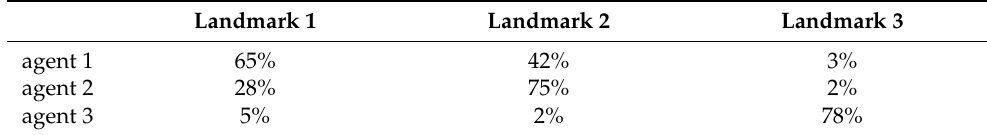
Table 2. Percentage of episodes where agents were able to cover all landmarks, when two “Sheldon” agents covered two fixed landmarks and the given agent trained with the vanilla MADDPG had only one free landmark to cover. Agent and landmark numbers refer to their positions in